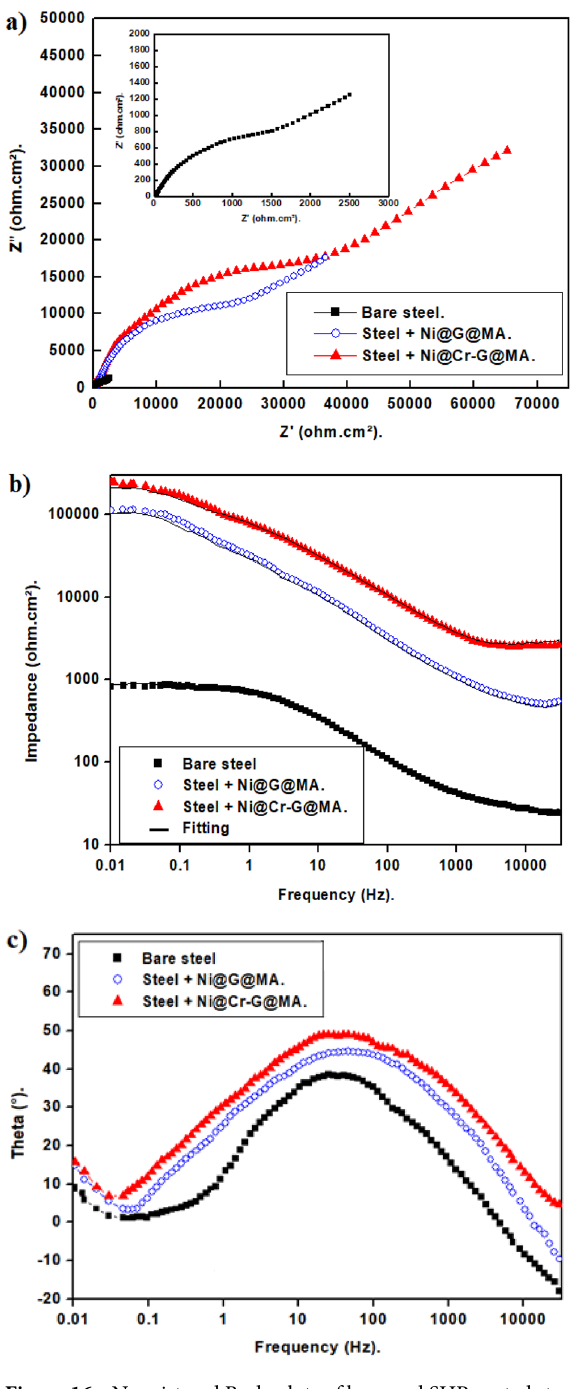
Figure 16. Nyquist and Bode plots of bare and SHP coated steel in 0.5 M NaCl solution.